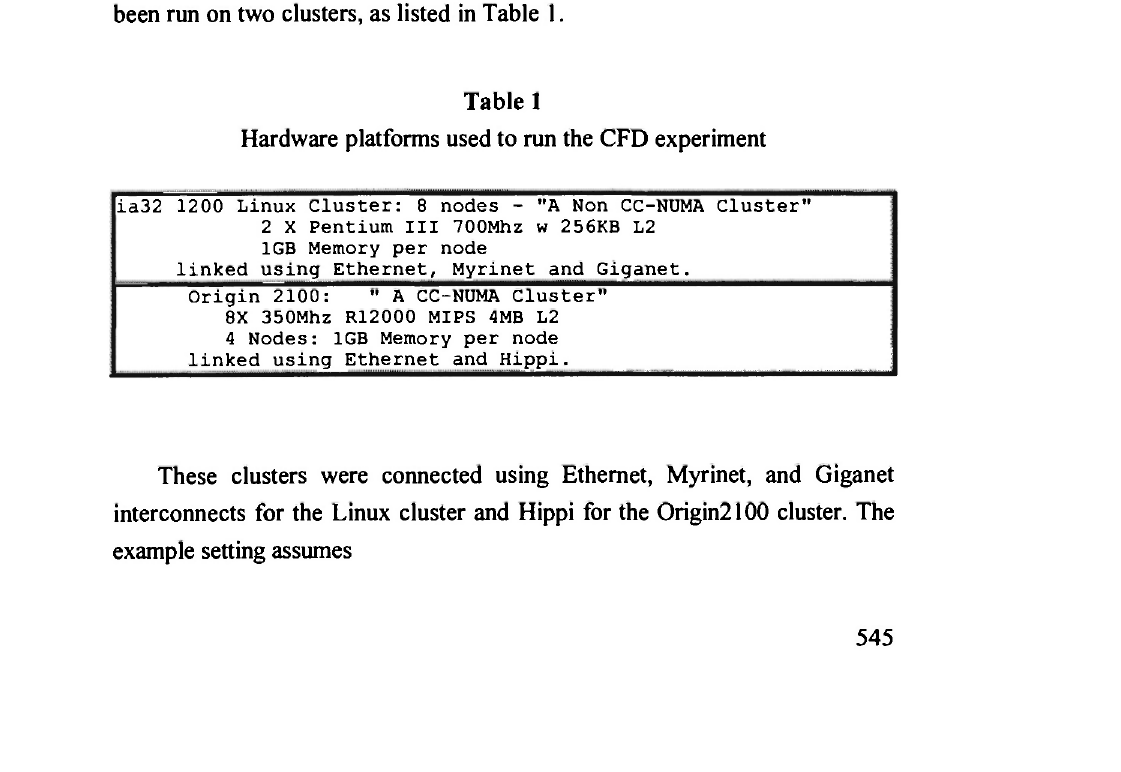
Hardware platforms used to run the CFD